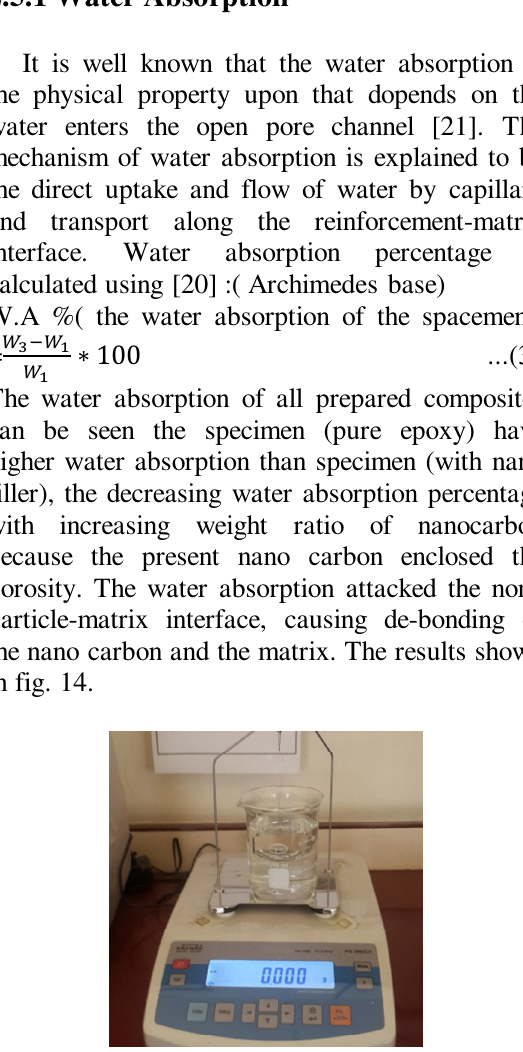
Fig. 13. Sensitive Libra used (division 0.001g) with Hang system.